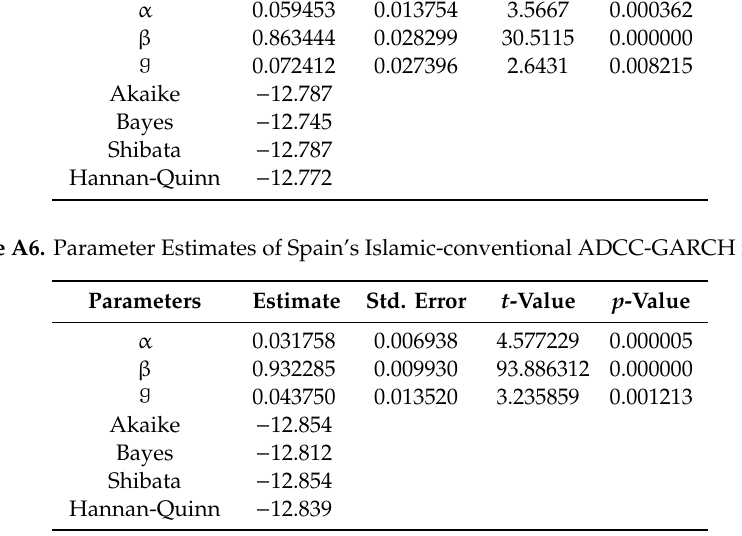
Table A2. Parameter Estimates of New Zealand’s Islamic-conventional ADCC-GARCH model. Table A7. Parameter Estimates of Czech Republic’s Islamic-conventional ADCC-GARCH model. Table A3. Parameter Estimates of China’s Islamic-conventional ADCC-GARCH model. Table A1. Parameter Estimates of Hong Kong’s Islamic-conventional ADCC-GARCH model. Figure A4. Islamic-conventional stock returns Wavelet correlations for Americas’ region markets.